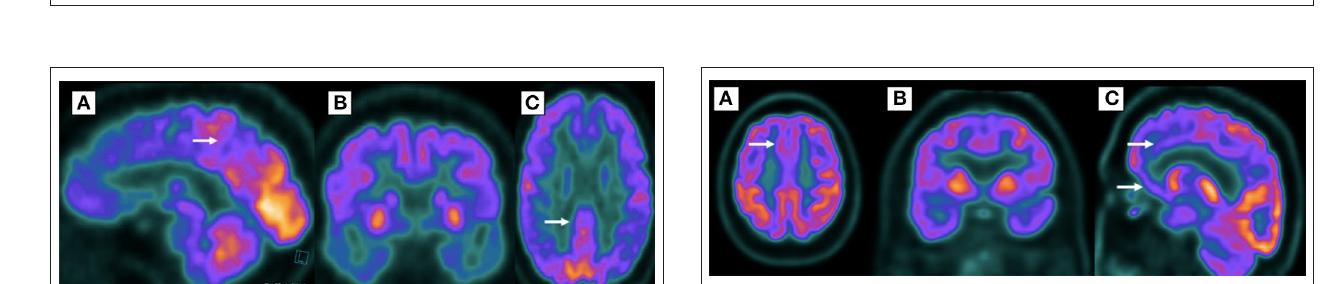
FIGURE 3 | Diffuse glycolytic hypometabolism in posterior parietal regions, extending bilaterally to precuneus (A) , temporal (B) , posterior cingulate gyrus (C) , and frontal lobes in 18-fluorodeoxyglucose positron emission tomography.